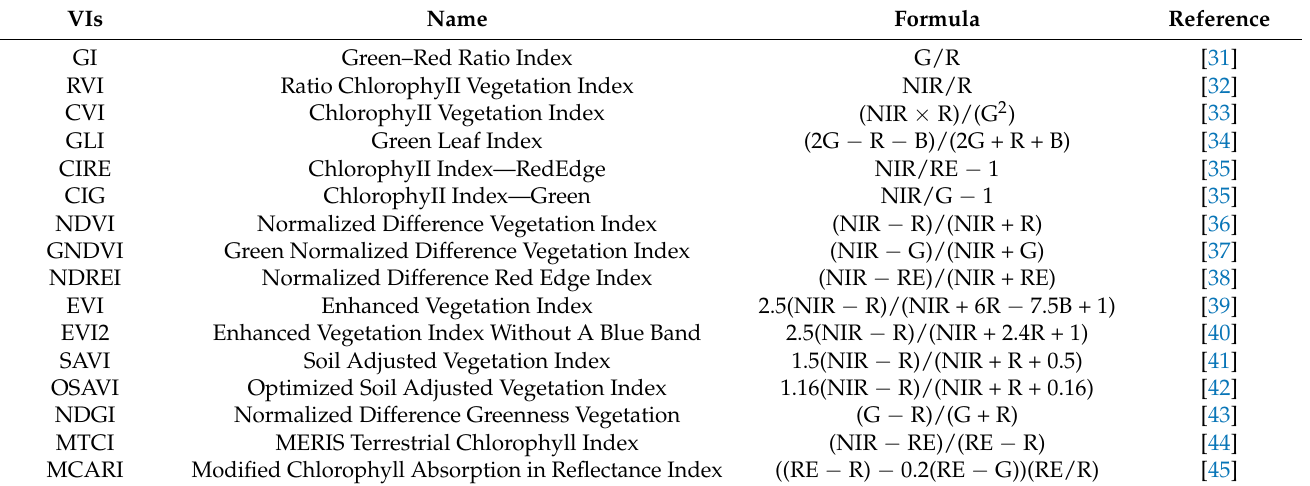
Table 2. Definition and calculation formula of the selected vegetation indices (VIs) in this